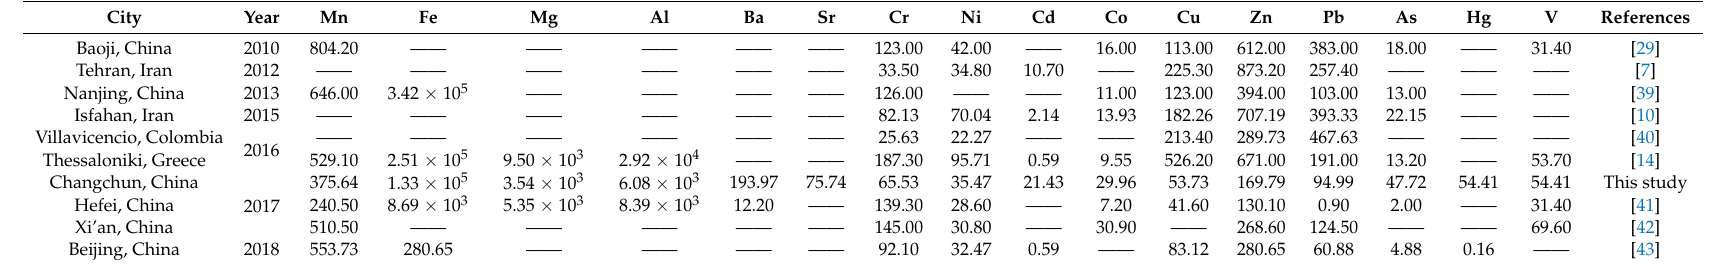
Table 4. Elements concentrations (mg kg − 1 ) in road/street dust of different cities in China and other